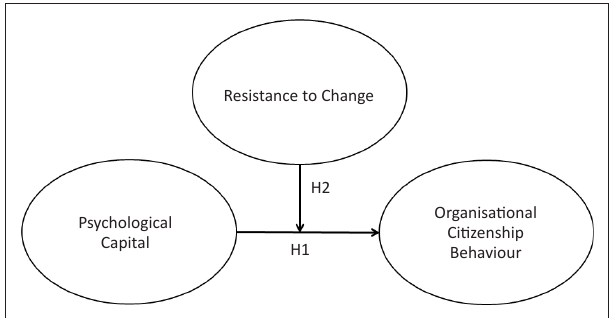
FIGURE 1: The theoretical framework and